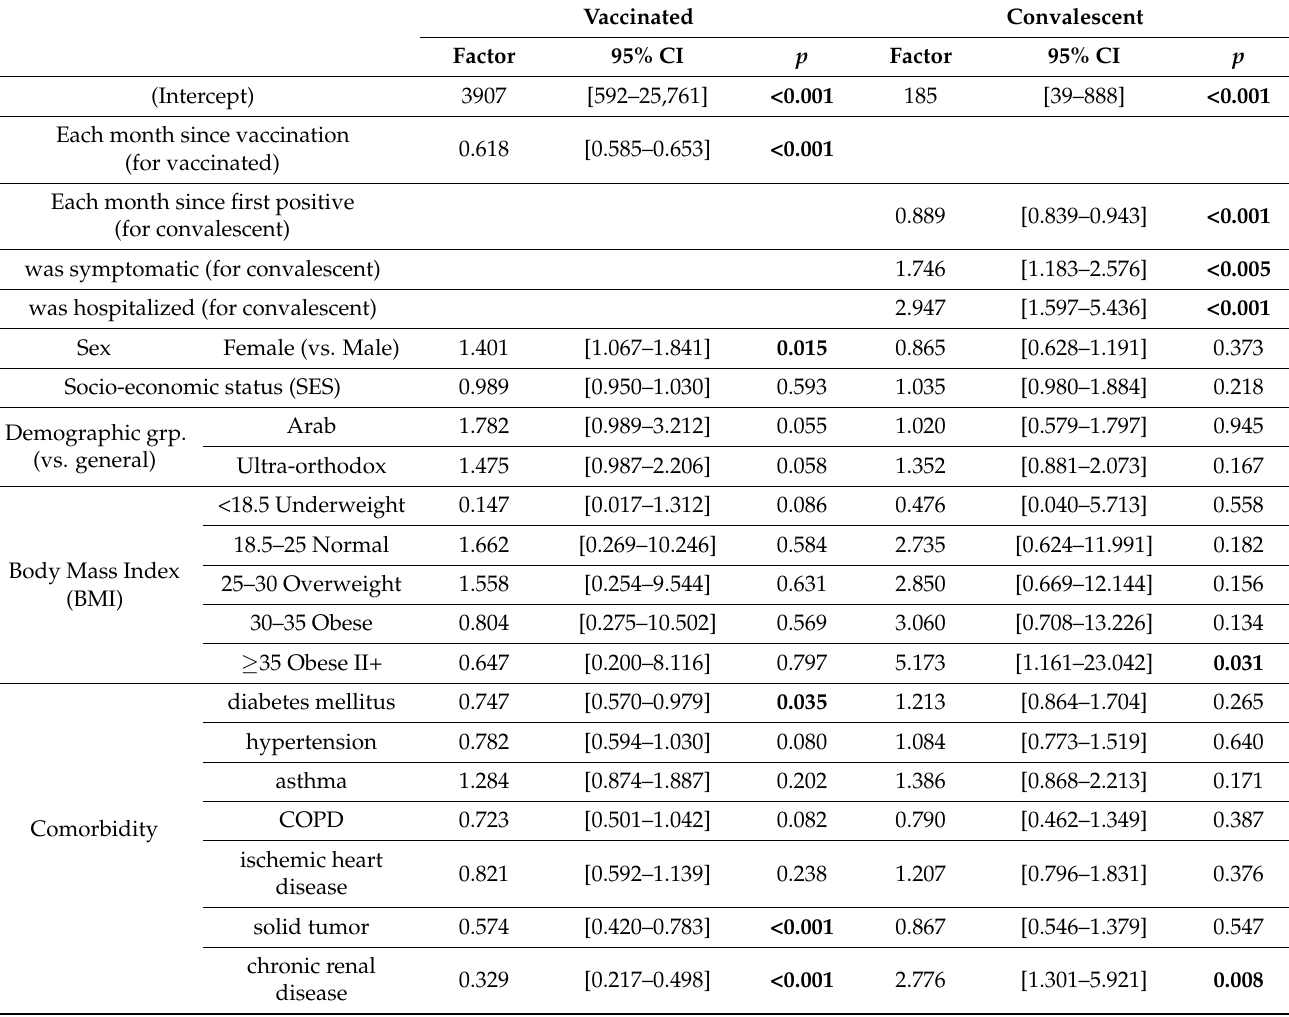
Table 6. Linear regression models of SARS-CoV-2 IgG antibody titer assuming linear decay with time analyzing only individuals of age ≥ 60. Regression coefficients were obtained by fitting a multivari- able linear regression model for the log of antibody titer. They are displayed after exponentiation; they are therefore multiplicative: the expected antibody titer equals the intercept multiplied by each factor. Significant P -values are shown in bold font.